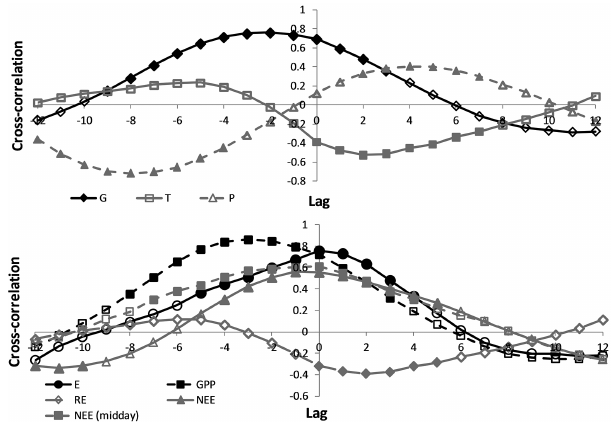
Figure 5. Cross-correlation functions between (cid:49)G MA , (cid:49)T MA , (cid:49)P MA , (cid:49)E MA , (cid:49) GPP MA , (cid:49) RE MA , (cid:49) NEE MA and midday (cid:49) NEE MA values and SST anomalies in the Nino4 zone of the equa- torial Pacific. Filled symbols correspond to p value<0.05 and non- filled symbols – to p >0.05. The time lag is expressed in